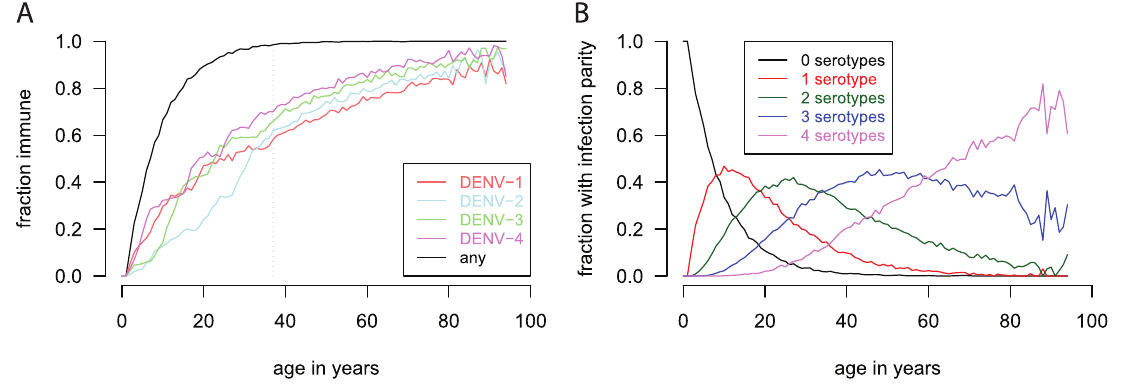
Figure 3. Prior exposure to the four dengue serotypes in the model’s synthetic population. Simulated pre-existing immunity to the dengue serotypes in Bang Phae by age. We assume constant relative serotype prevalence before 1973, which corresponds to the vertical dotted line. Surveillance data is scaled as described in Text S2. (A) The age-specific fraction of the population immune to the four dengue serotypes. The black curve is the fraction of the population exposed to one or more of the serotypes (i.e., infection parity w 0 ). (B) The age-specific fraction of the population immune to a given number of the four dengue serotypes (infection parities). The black curve the fraction of the population exposed to none of the serotypes (i.e., infection parity ~ 0